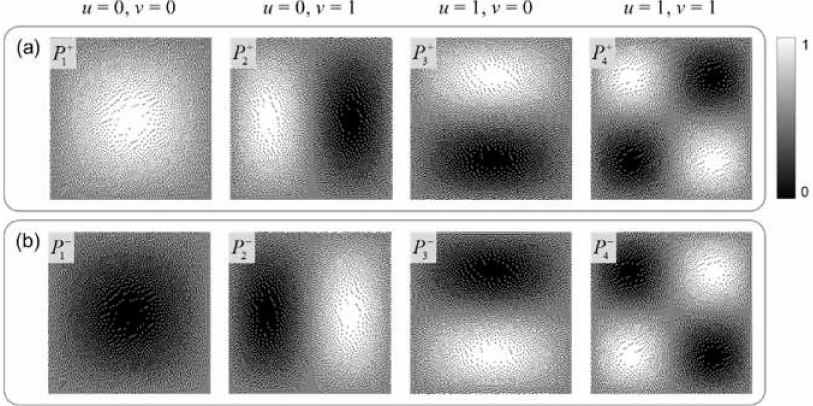
Figure 4. Binarized basis patterns: ( a ) binarized basis patterns of the first four coefficients and ( b ) inversed patterns of ( a